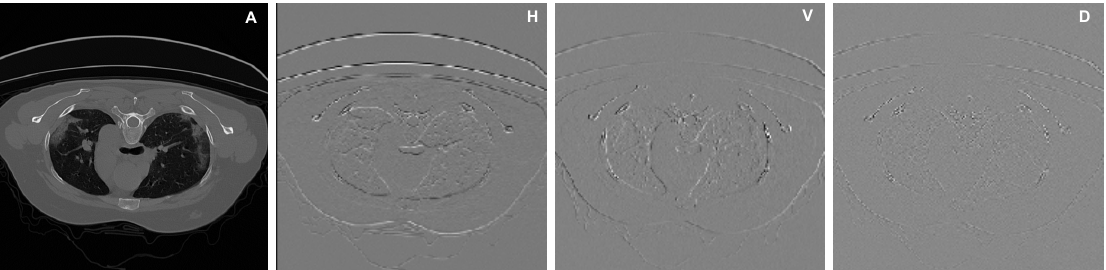
Figure 5. Illustration of a zoom-in visualization of decomposing a CT image into four sub-bands using DWT. A, H, V and D refer to Approximation, Horizontal Detail, Vertical Detail and Diagonal Detail,